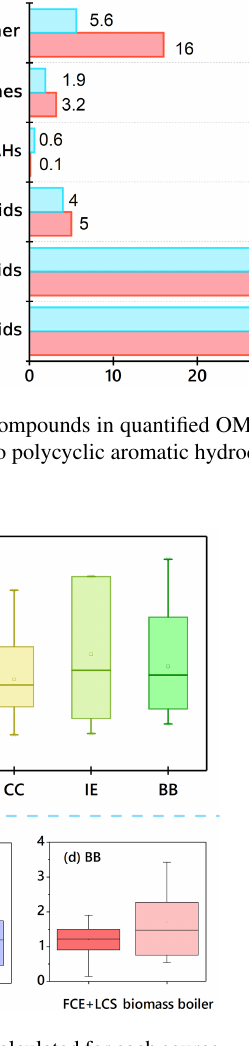
Figure 15. Coefficients of variation (CV) calculated for each source category. SD denotes soil dust, RD denotes road dust, VE denotes vehicle emissions, CE denotes cooking emissions, CC denotes coal combustion, IE denotes industrial emissions, BB denotes biomass burning, WFGD denotes wet flue gas desulfurization, DD denotes dry desulfurization, DTSM denotes the dilution tunnel sampling method, RSM denotes the resuspension sampling method, FCE de- notes field combustion experiment, and LCS denotes laboratory combustion